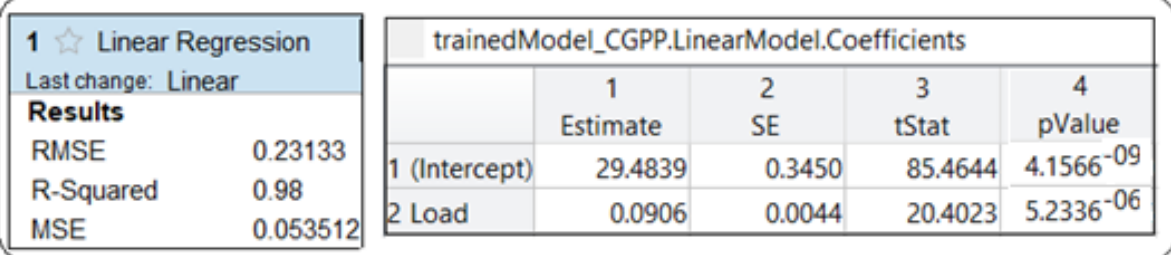
( a ) Regression model ( b ) Derived from regression results Figure 2. Prediction plots of CGPP efficiency with regression ( a ) and derived from regression model ( b ). The coefficients obtained in the linear regression analysis are used for predictions, and the related function for the overall efficiency of the CGPP is shown in (6). η (cid:3042)(cid:3049)(cid:3032)(cid:3045)(cid:3028)(cid:3039)(cid:3039) = (0.0906 ∗ % 𝐿𝑜𝑎𝑑) + 29.4839 (6) The linear regression–linear model results of the RMSE of 0.2313, R -squared of 0.98, MSE of 0.05351, MAE of 0.2018 and p -values of 5.2336 × 10 − 6 for the load and 4.1566 × 10 − 9 for the intercept indicate that the regression model is perfectly fit for this problem. The